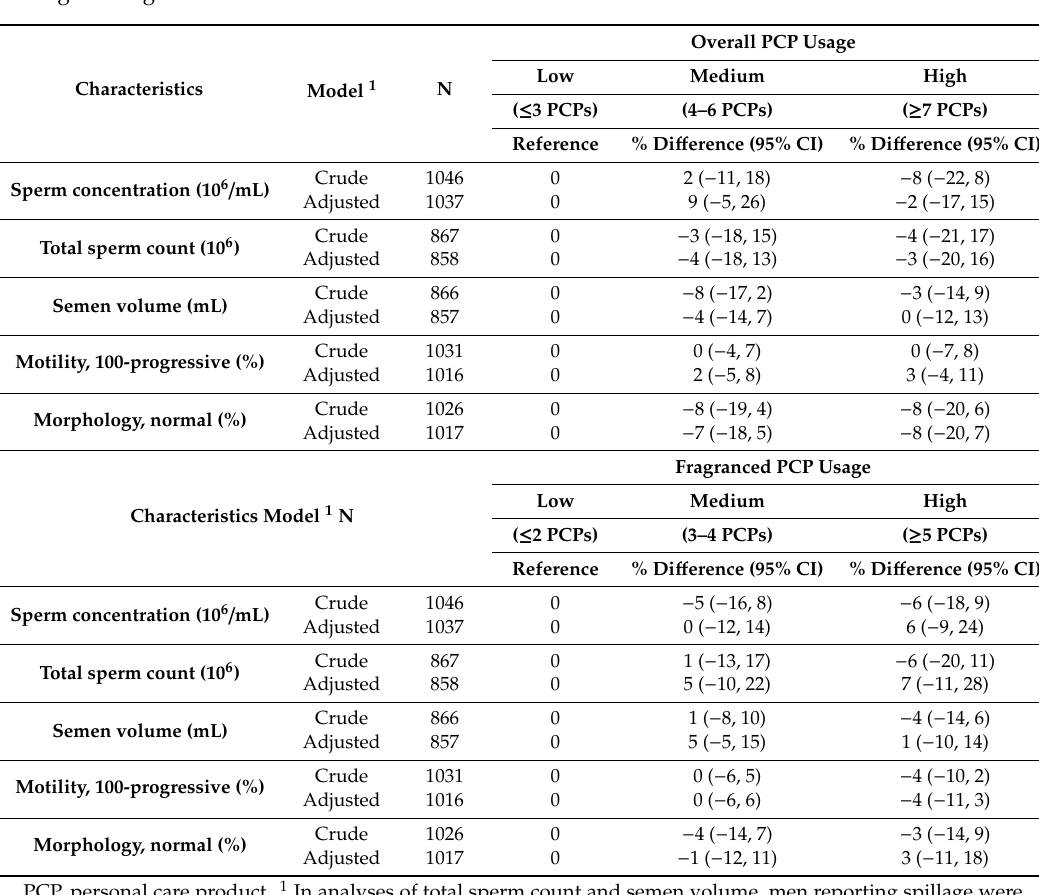
Table 5. Negative binomial regression analyses of semen characteristics in relation to aggregated PCP usage among the 1046 men in the FEPOS